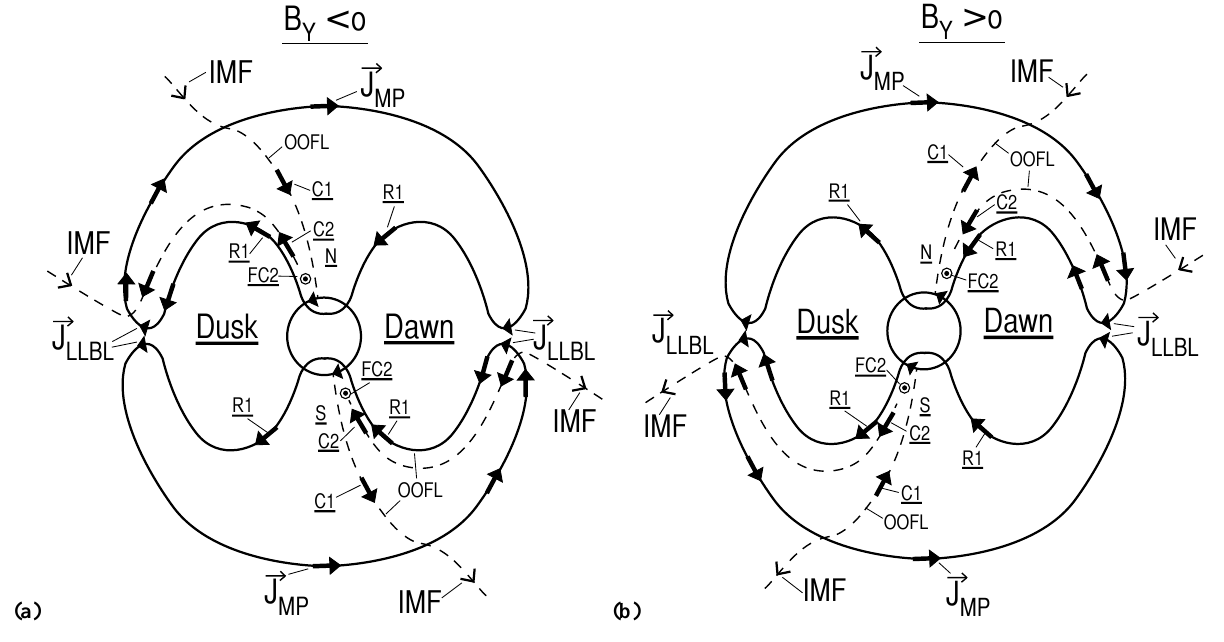
Fig. 1. Schematic illustration of current systems related to flow channel FC 2. Panel (a) shows event categories NH-dusk/ B y < 0 (top left) and SH-dawn/ B y < 0 (bottom right). Panel (b) shows the types NH-dawn/ B y > 0 (top right) and SH-dusk/ B y > 0 (bottom left). The corresponding IMF-magnetosphere interconnection topologies are marked by an old open field line (OOFL). The perspective is from the magnetotail towards the Sun. (North is up and Dusk is to the